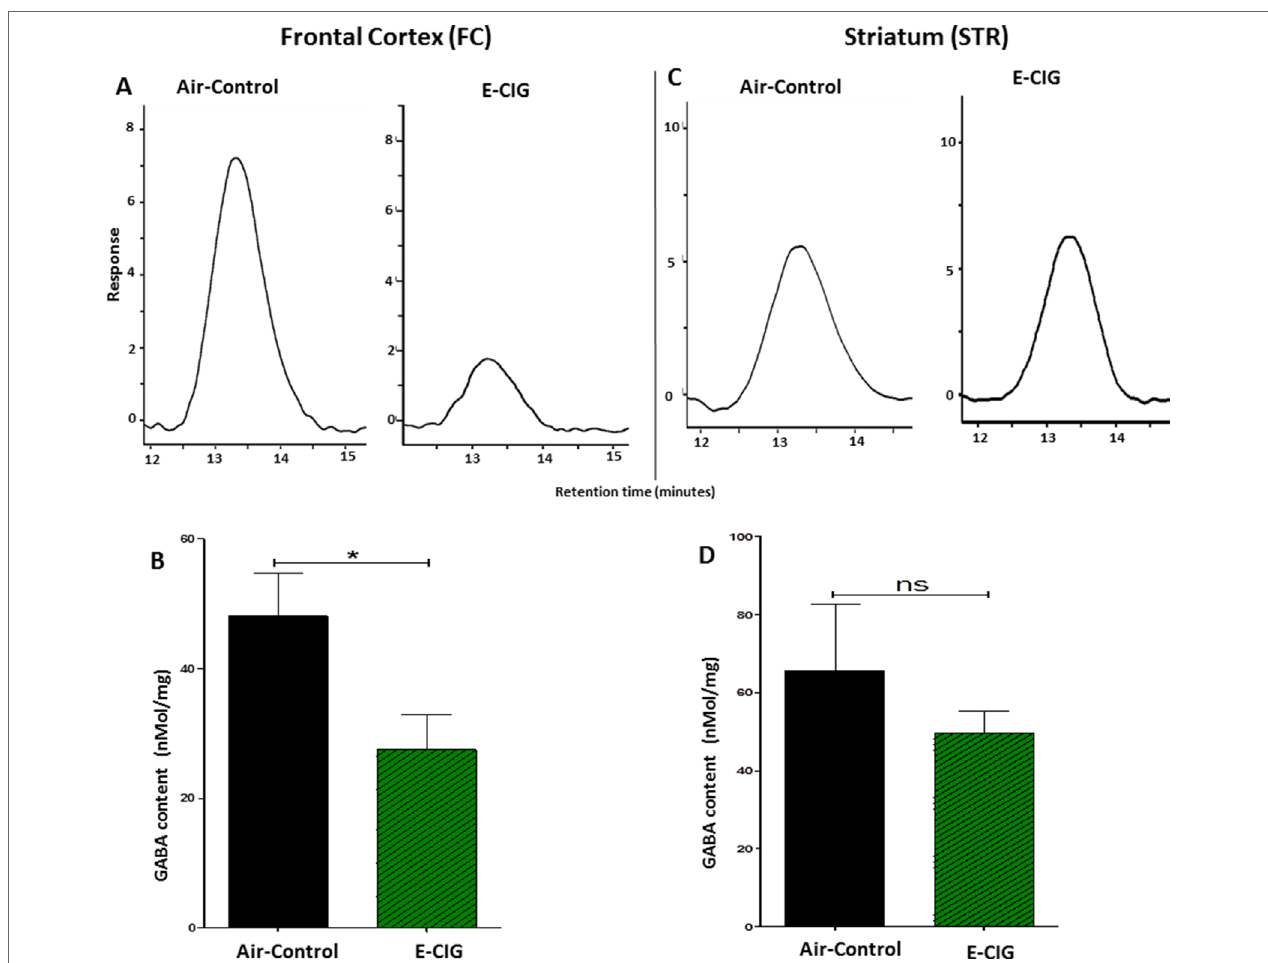
FIGURE 5 | Effects of inhalation of E-CIG for 6 months on GABA concentrations in the FC and STR in male C57BL/6 mice. (A) Peaks of GABA in the FC in air control and E-CIG groups. (B) Independent t -test analysis revealed that there is a significant reduction in GABA concentration in the FC in E-CIG-exposed group compared to air controls. (C) Peaks of GABA in the STR in air control and E-CIG groups. (D) Independent t -test analysis did not show any significant alterations in GABA concentration in the STR between E-CIG-exposed group and air controls. Data are reported as mean ± SEM (* p < 0.05, ns, not significant), ( n = 5 for each group), ( X -axis, retention time [minutes], Y -axis,